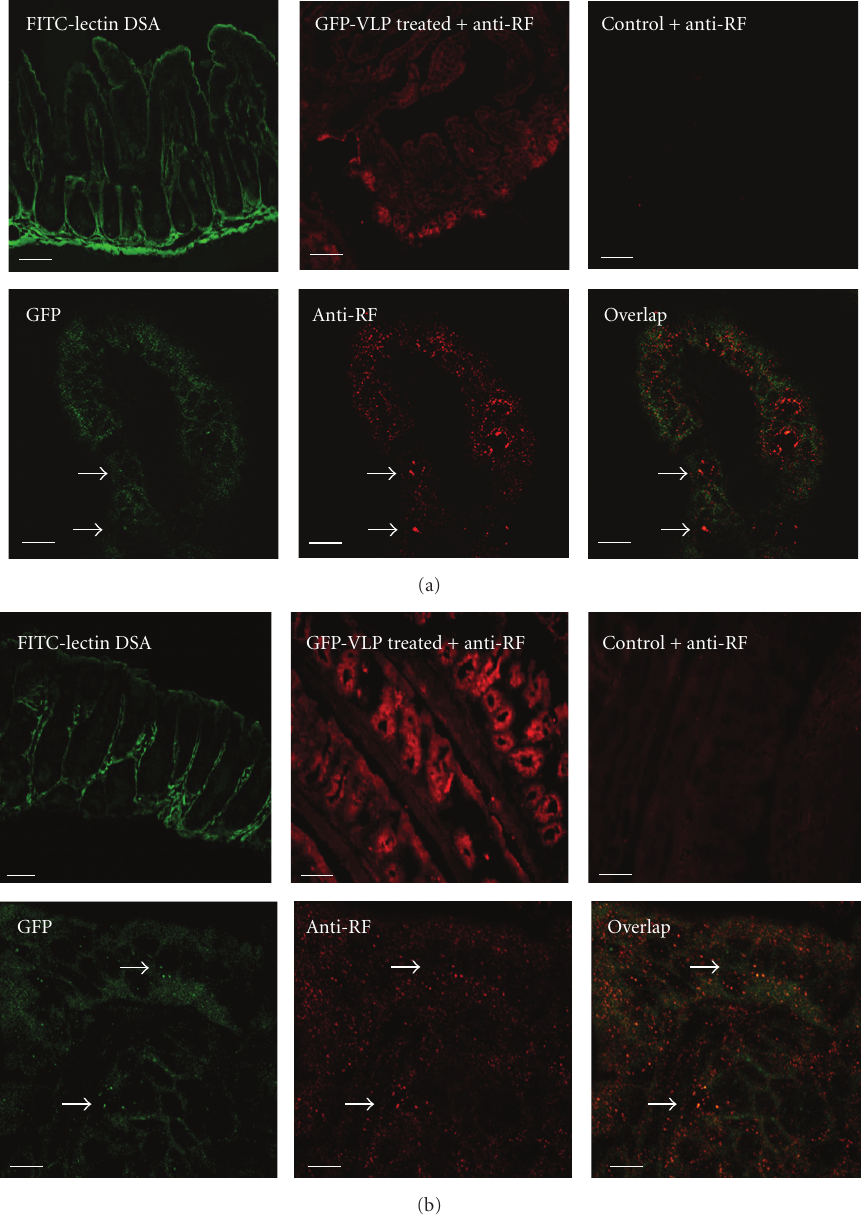
Figure 4: Complete VLP internalize in vivo in the ileum (a) and colon (b) . Frozen sections of intestinal samples from mice administered with complete GFP-VLP (green) were labeled with anti-RF antibodies and Cy3-conjugated (red); FITC-lectin DSA was used as a positive control. Tissue sections were analyzed by confocal microscopy. Overlay analysis shows that GFP colocalizes with viral proteins (yellow/orange). The arrows indicate the VLP. Representative images of 3 experiments are shown. Scale bar 20 μ